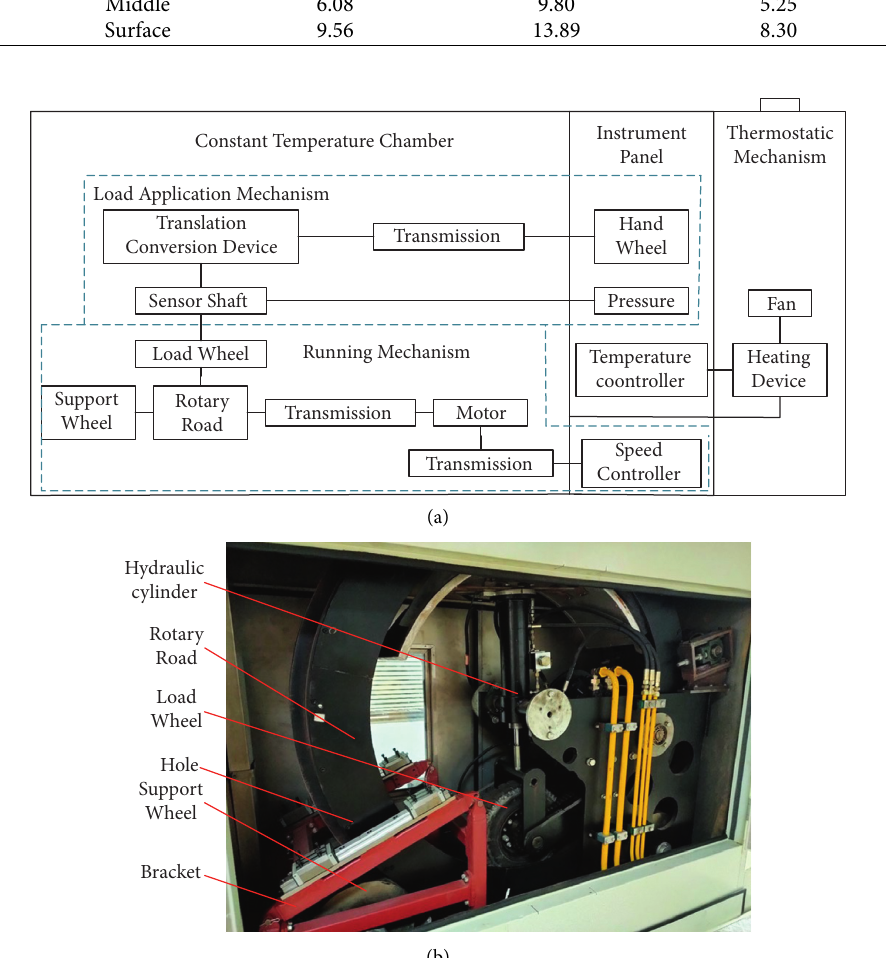
Figure 9: Vertical loaded circle-road tester. (a) Schematic diagram. (b) Actual